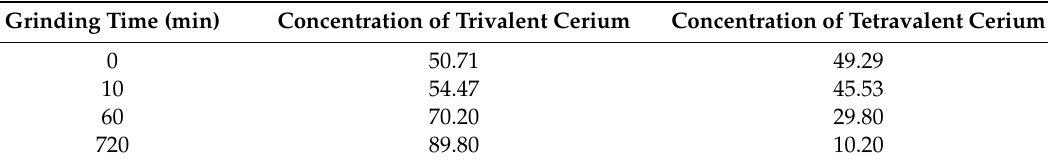
Table 4. Concentrations of tri- and tetravalent cerium in samples with and without grinding, based